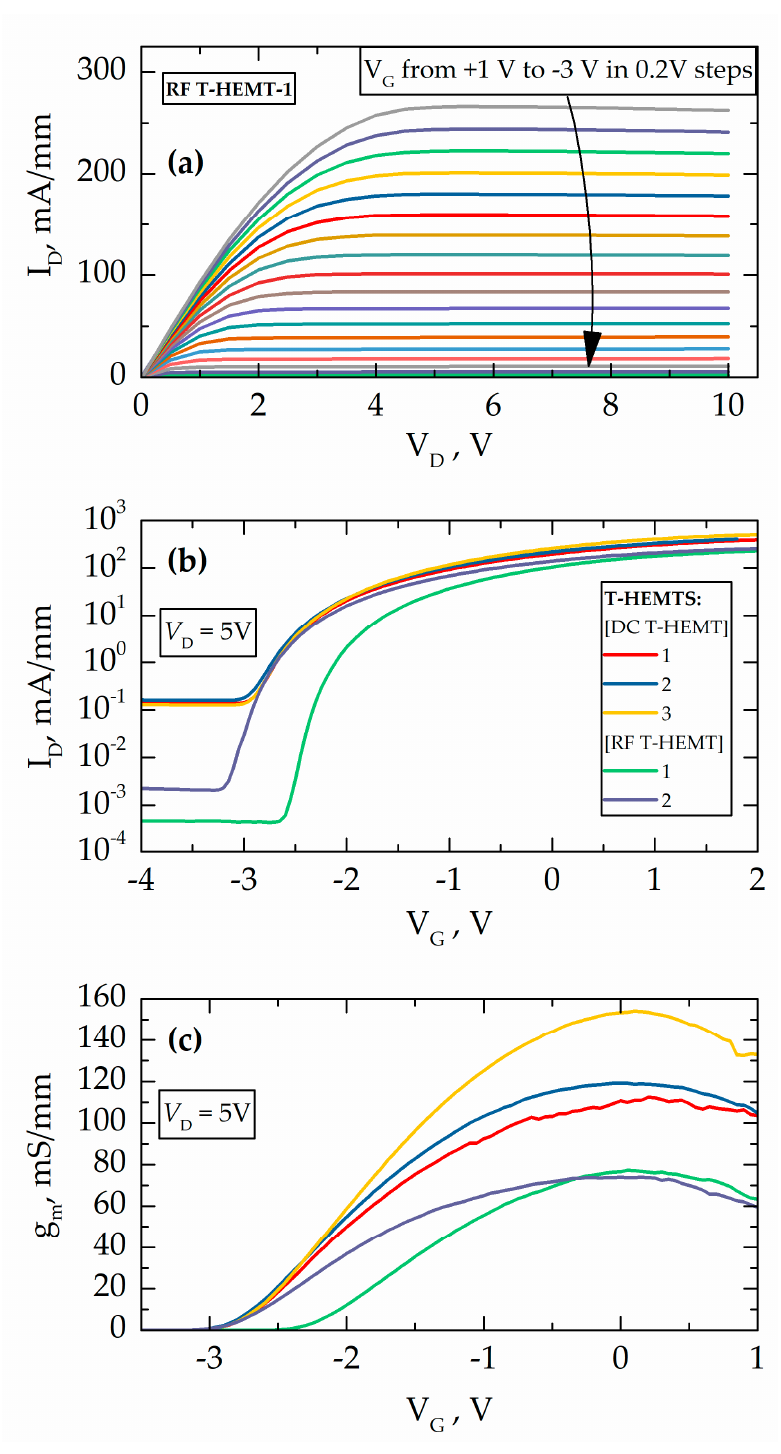
Figure 8. DC characteristics of T-HEMTs under study: ( a ) DC output characteristics of 0.4 mm wide RF T-HEMT-1 and comparisons of transfer ( b ) and transconductance ( c ) characteristics of the RF T-HEMTs and DC T-HEMTs with various values of the channel widths W Ch . The gate length for all devices is 5 μ m.